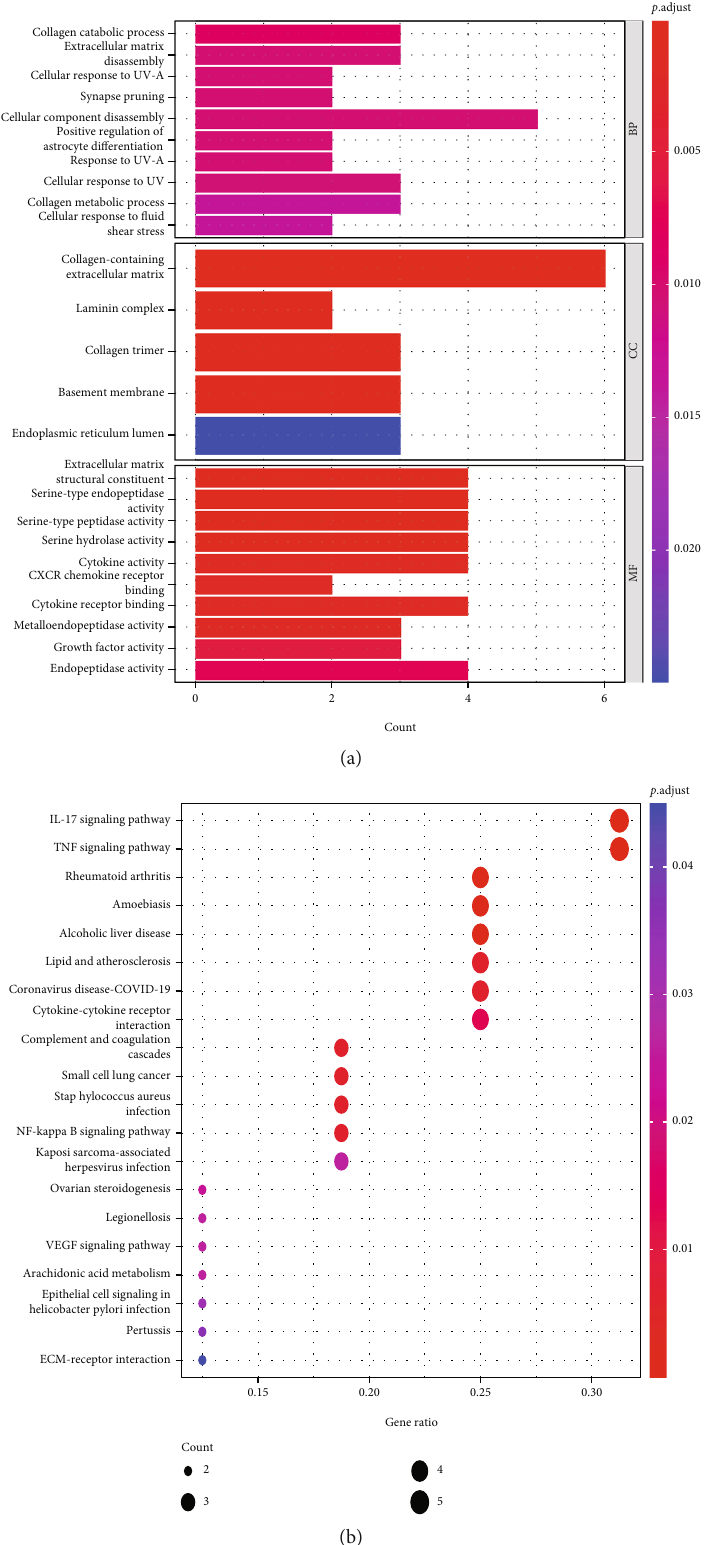
Figure 8: GO and KEGG analysis of di ff erential genes. (a) Histogram of GO enrichment analysis of di ff erential genes. (b) Bubble plot of KEGG enrichment analysis of di ff erential